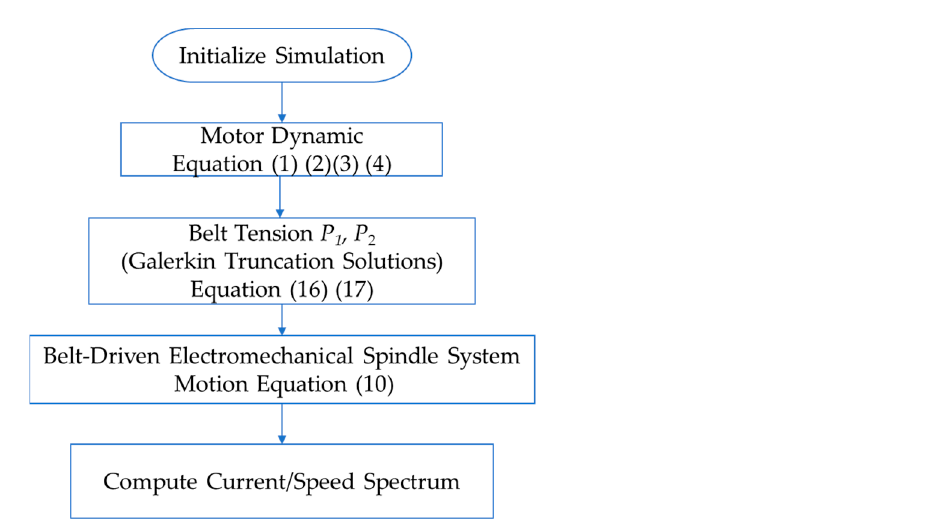
Figure 5. Flowchart for solving dynamic equations using an explicit Runge–Kutta method in MATLAB platform.